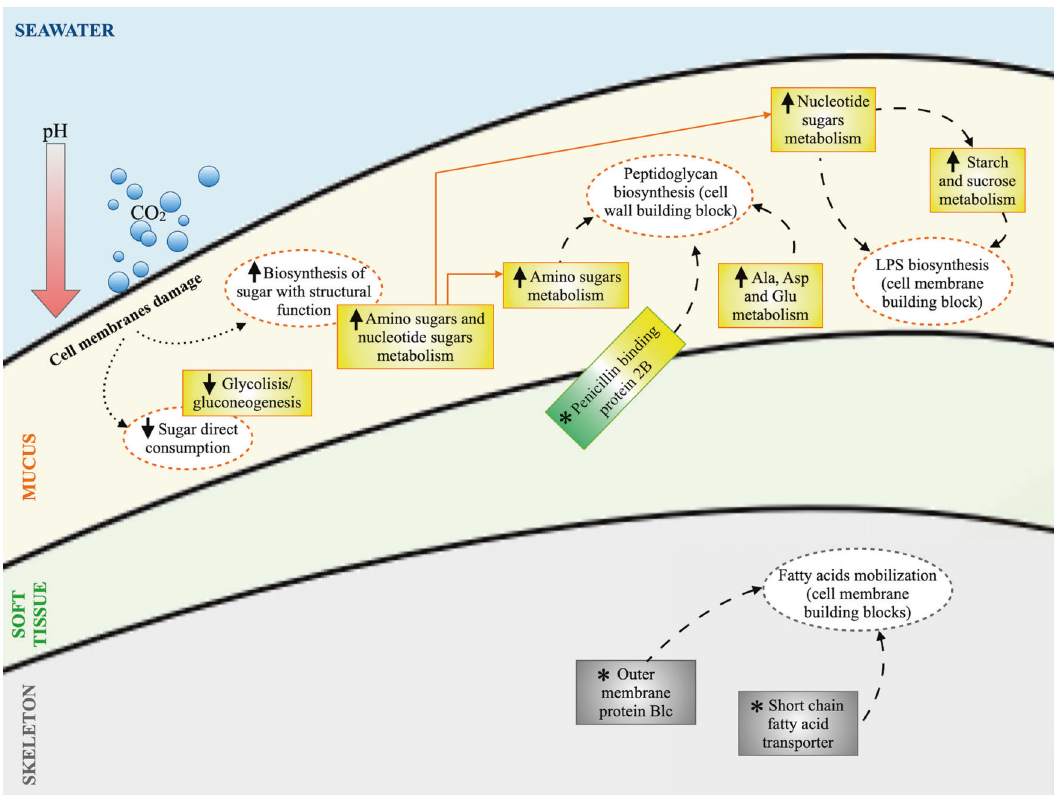
Fig. 4 Proposed model of carbohydrate metabolism shift in coral microbiomes under acidi fi cation conditions, from direct energy production to structural maintenance pathways. KEGG pathways and KO entries showing acidi fi cation related modi fi cations in relative abundance or prevalence, respectively, are reported in rectangles using the same color code of the coral compartment in which variations were observed (mucus, yellow; soft tissue, green; skeleton, gray). Upward and downward arrows indicate that the KEGG pathway increased or decreased in terms of relative abundance with the increasing acidi fi cation, respectively. Reported KO entries (*) were detected in all replicates from the highly acidi fi ed site while absent in samples from control sites. Cell functions hypothesized to be connected with the variations of KEGG pathways abundance and KO entries detection are reported in dashed circles. Dotted arrows represent the in fl uence of acidi fi cation on carbohydrates utilization. Dashed arrows represent connections between observed increasing/decreasing pathways and cell functions. Abbreviations: LPS lipopolysaccharides; Ala Alanine; Asp Aspartate; Glu